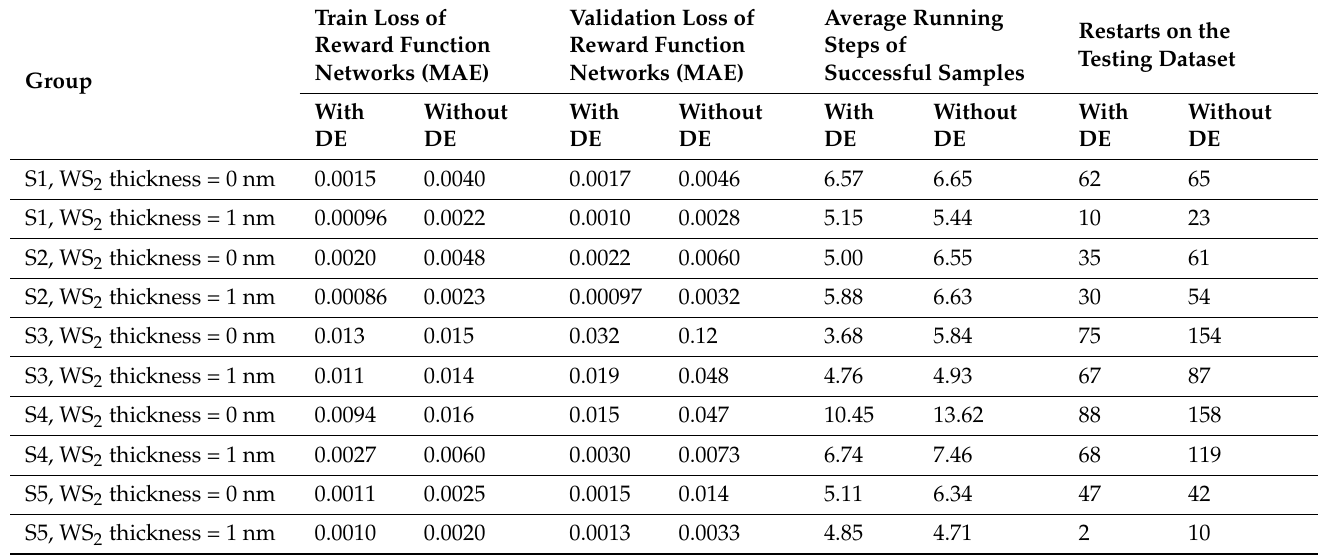
Table 2. Loss and running performance metrics of the DEDGO